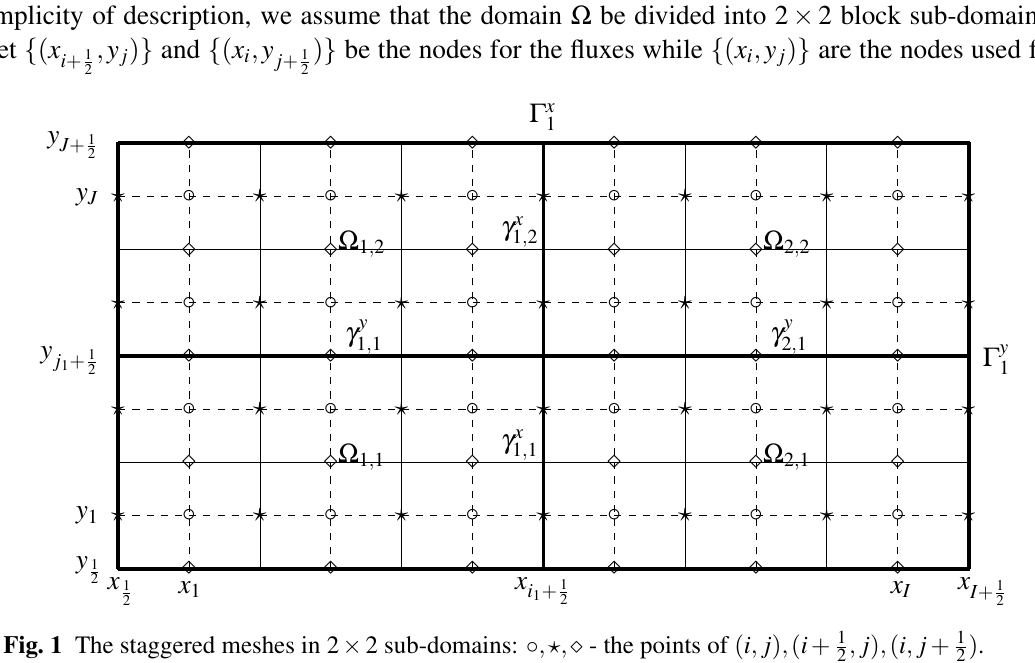
, j ) , ( i , j + 1 ) . 2 2 : y = y is the interface of sub-domains Ω p , 1 and j 1 + 1 1 2 along y − 1